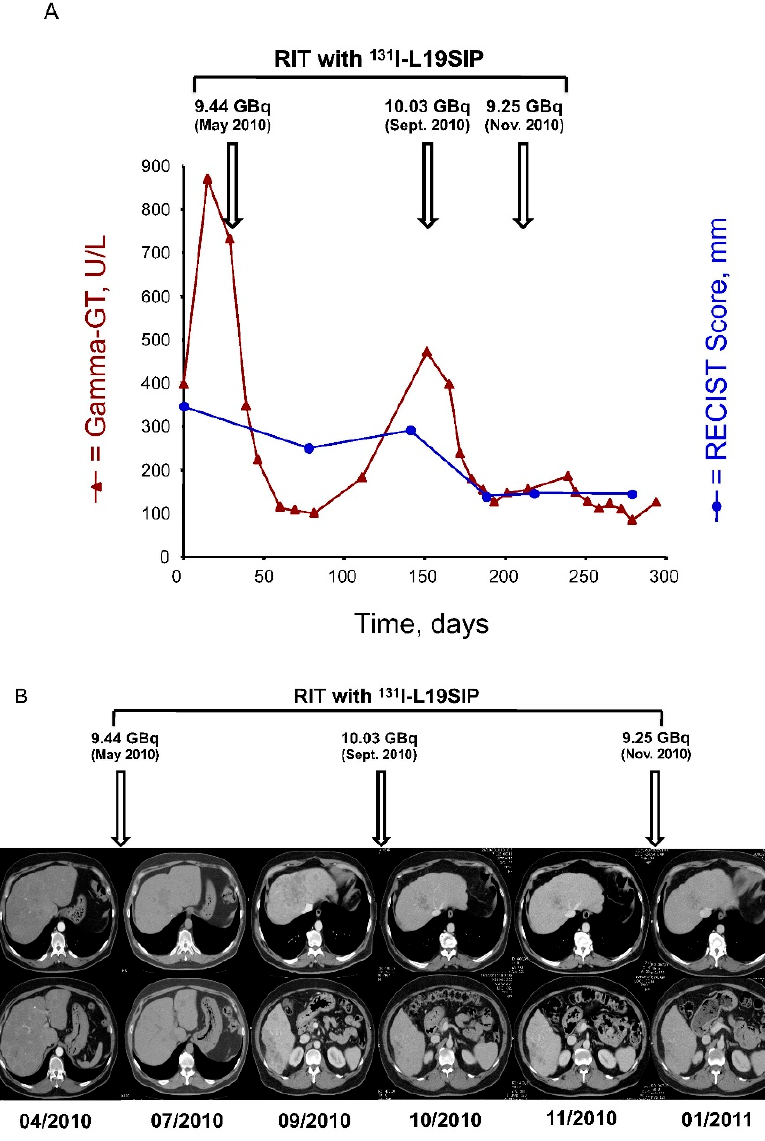
Figure 2. ( A ) Time course of changes in RECIST score (sum of maximum diameters of each target tumor lesion, expressed in mm) and in serum values of Gamma-GT (in U/L) over the period April 2010–February 2011. Over this period, three subsequent courses of R-RIT were administered, as indicated by arrows. The plots show objective responses after each R-RIT both in the serum marker of disease burden and in the RECIST score ( − 27.7% after R-RIT of 05/2010; − 51.2% after R-RIT of 09/2010; disease remained stable after R-RIT of 11/2010). Each reduction in the Gamma-GT serum levels corresponded to considerable improvement of clinical symptoms (mostly nausea and vomiting). ( B ) CT slices showed the liver lesions of the VIII segment (top line) and the VI segment (bottom line) over the period April 2010–January 2011. Over this period, three subsequent courses of R-RIT were administered, as indicated by